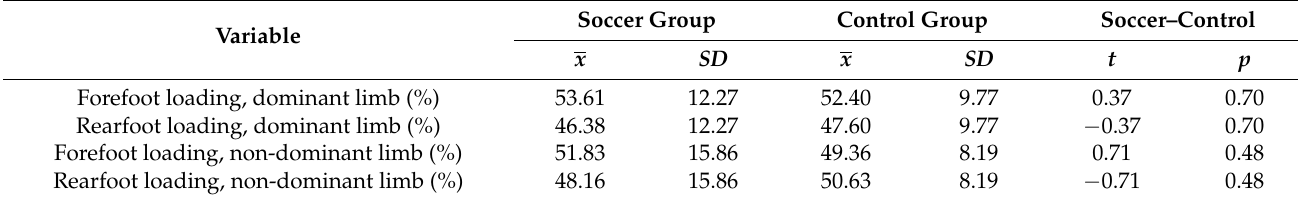
Table 3. Mean ( x ), standard deviation (SD) and t-test results for plantar pressure distribution in the dominant and non-dominant limbs (forefoot/rearfoot loading) in the static